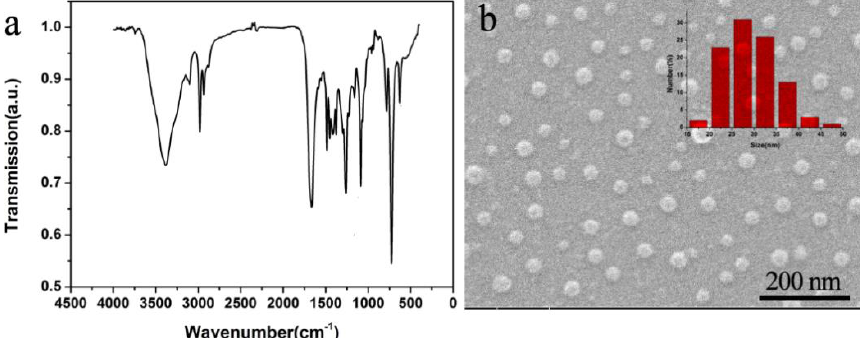
Figure 1. ( a ) Fourier Transform infrared spectroscopy and ( b ) morphologies of the PNVPY